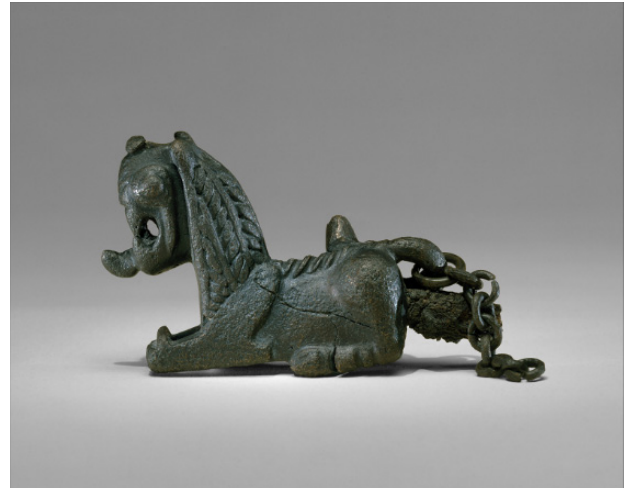
Figure 23. Garment (?) pin in form of lion (MMA acc. no 61.100.10); bronze ornament; Hasanlu, Iran; Iron Age II, ca. 9th cent. BCE [image courtesy of the Metropolitan Museum of Art, New York].